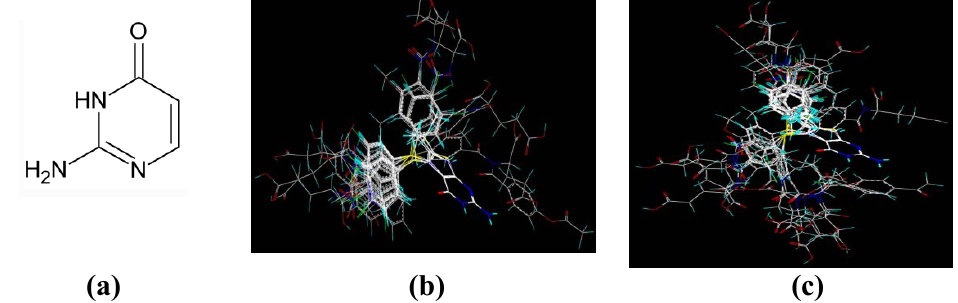
Figure 2. (a) Common substructure used for alignment. (b) Ligand-based alignment on common substructure (c) Receptor-based alignment on common